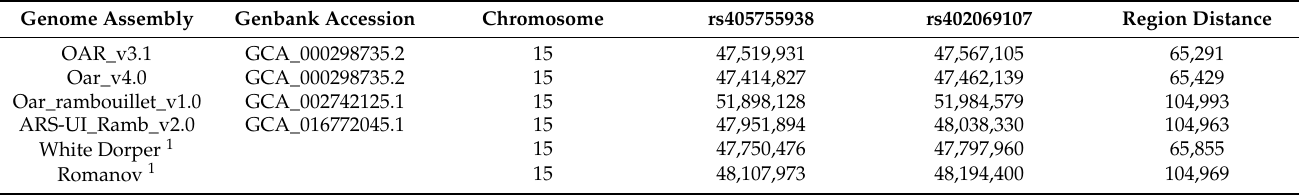
Table 2. Genomic position of markers used to predict β -globin haplotype.